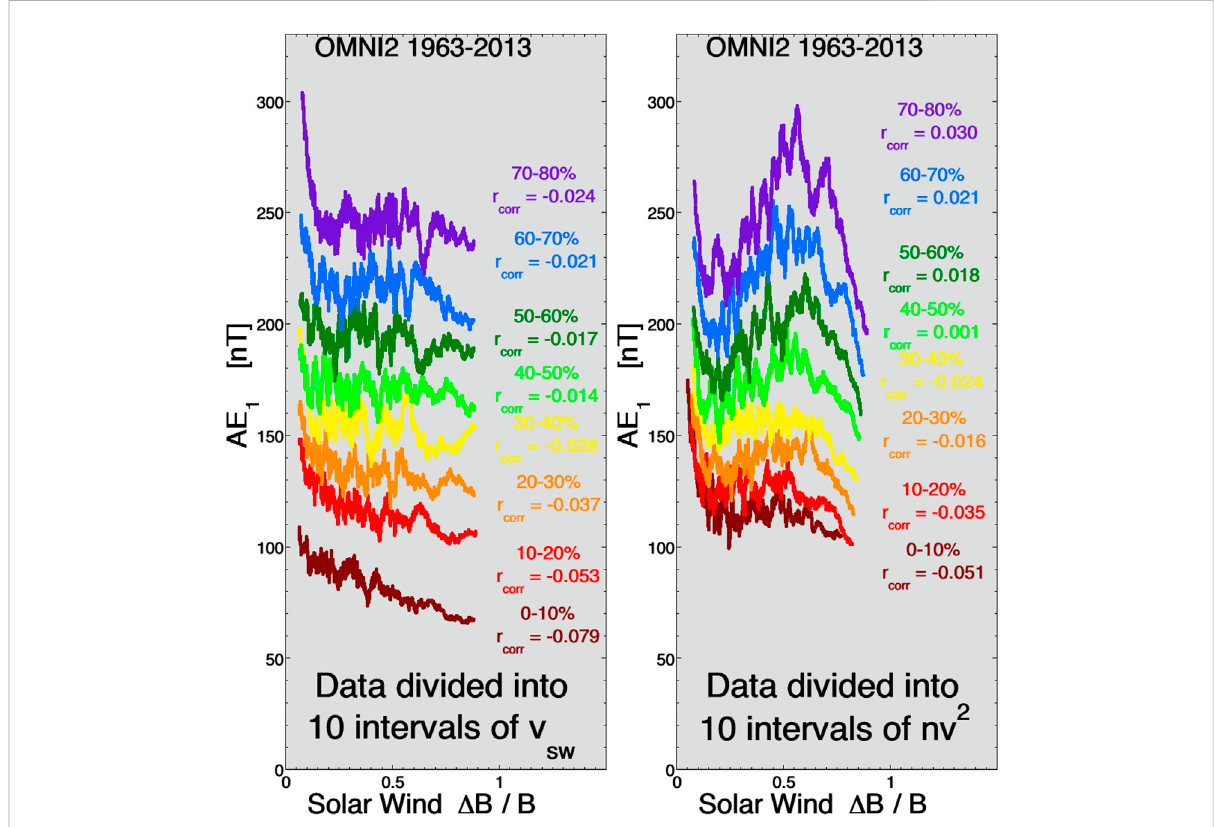
FIGURE 3 (left panel)For timeswhen thevalueofv sw isin 10-percentintervals,300-point runningaveragesoftheone-hour-lagged AEindexisplotted as afunctionoftheamplitude Δ B/Boftheupstreamsolar-windturbulence.(rightpanel)Fortimeswhenthevalueofthesolarwindrampressurenv 2 isin 10-percent intervals, 300-point running averages of the one-hour-lagged AE index is plotted as a function of the amplitude Δ B/B of the upstream solar-wind